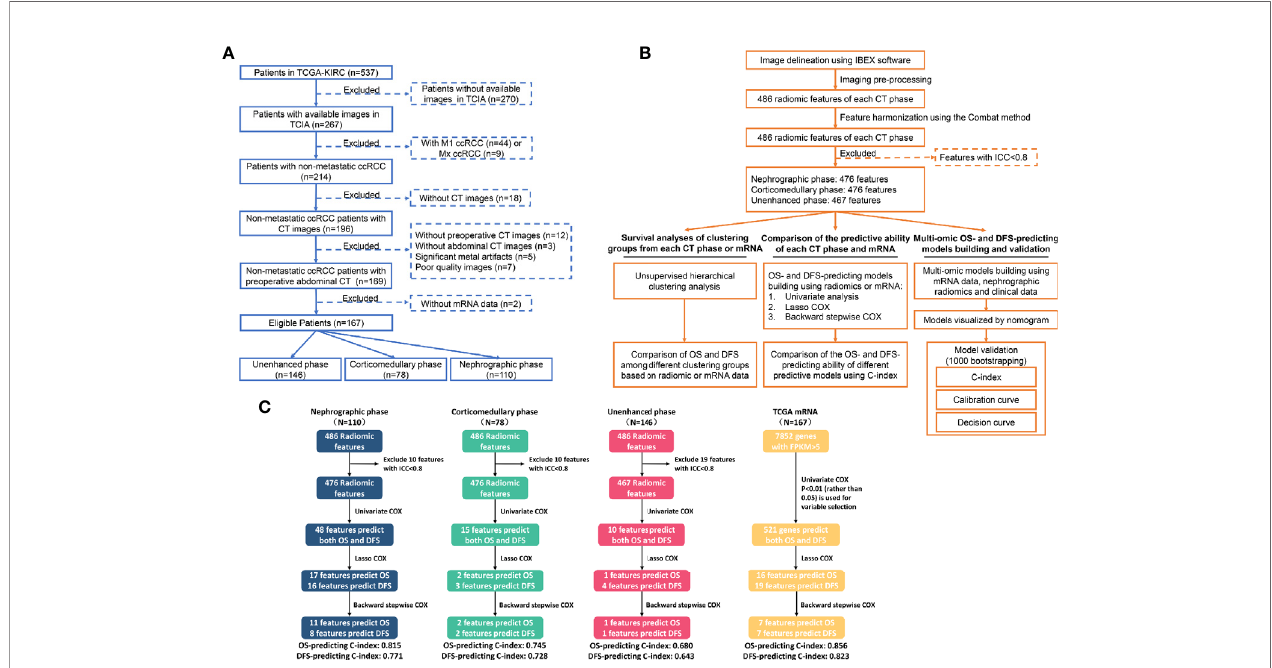
FIGURE 1 | Flowchart showing the inclusion criteria (A) , the detailed analytic strategy (B) and the results of the prognostic analyses (C) . TCGA, The Cancer Genome Atlas; TCIA, The Cancer Imaging Archive; ccRCC, Clear cell renal cell carcinoma; CT, Computed tomography; OS, Overall survival; DFS, Disease-free